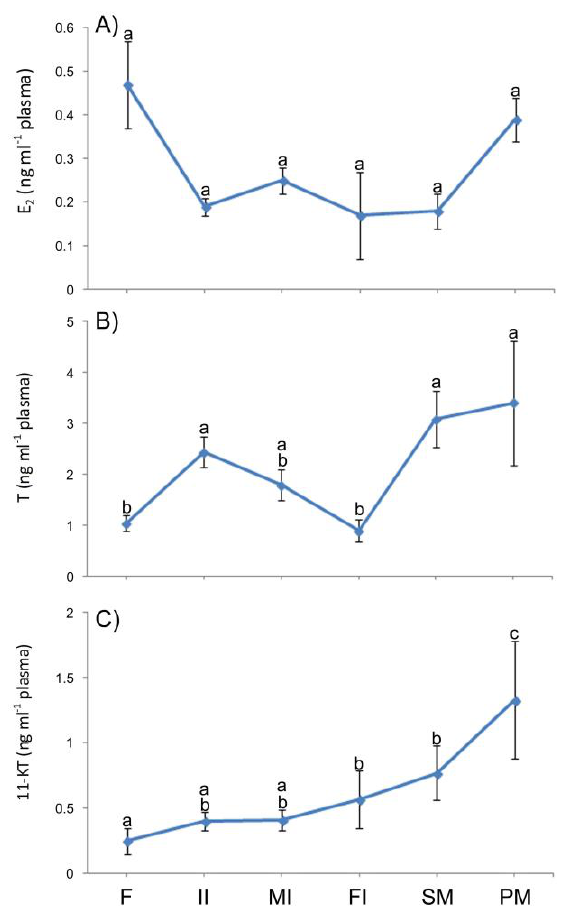
Figure 15. Plasma levels of: ( A ) 17 β -Estradiol (E2); ( B ) Testosterone (T); and ( C ) 11-Ketotestosterone (11-KT) (mean ± S.E.M) in the different sex types of S. marmoratus individuals. F: females ( n = 49), II: Initial intersexes ( n = 67), MI: Mid intersexes ( n = 35), FI: Final intersexes ( n = 4), SM: secondary male ( n = 24), PM: primary male ( n = 7). Different letters denote significant differences ( p <0.05).